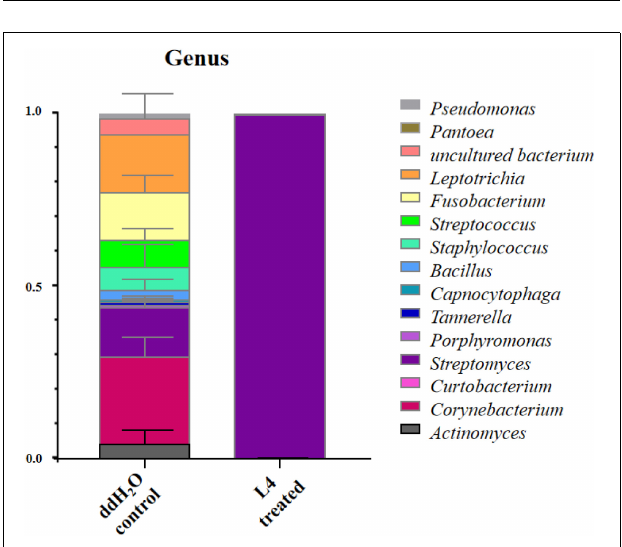
FIGURE 4 | Microscopic observation of A . thaliana roots after treatment with S . lincolnensis L4.